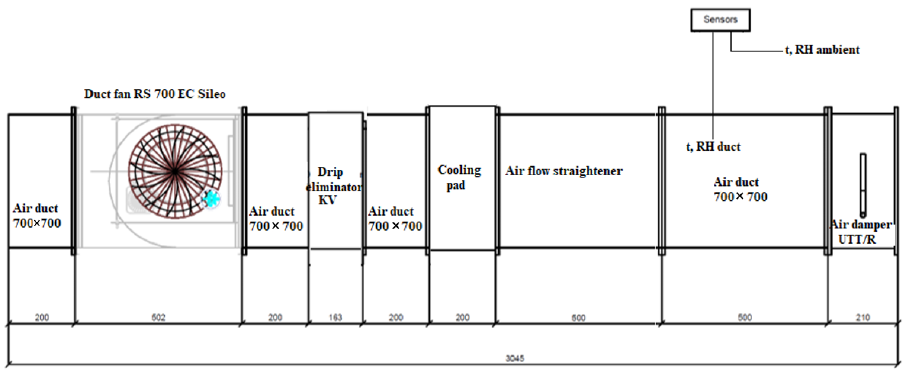
Figure 5. The layout of the testing setup.